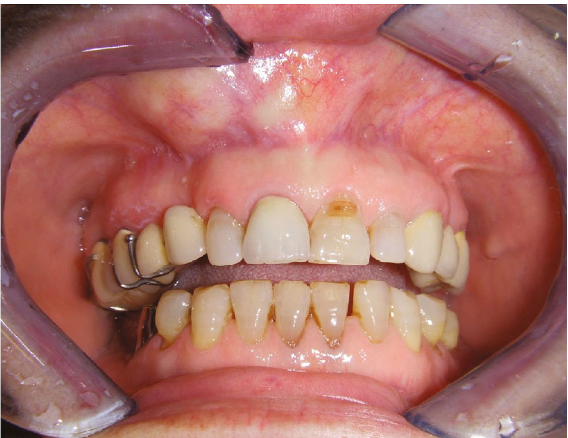
Figure 1: Clinical preoperative assessment. Swelling of the maxillary alveolar process is clearly shown just above the central and lateral